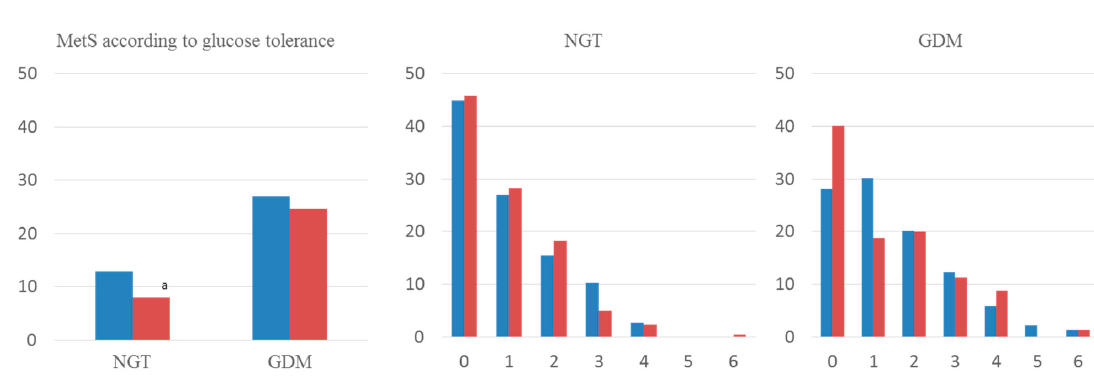
Figure 2. Presence of ( a ) complete MetS and IrS comparing standard-care and intervention groups and ( b ) of having from 0–6 components of MetS; and ( c ) complete MetS and of having 0–6 components of MetS by groups of glucose tolerance. MetS, metabolic syndrome; IrS, insulin resistance syndrome; GDM, gestational diabetes mellitus; NGT, normal glucose tolerance. a: p < 0.05; b: p < 0.01; c: p <